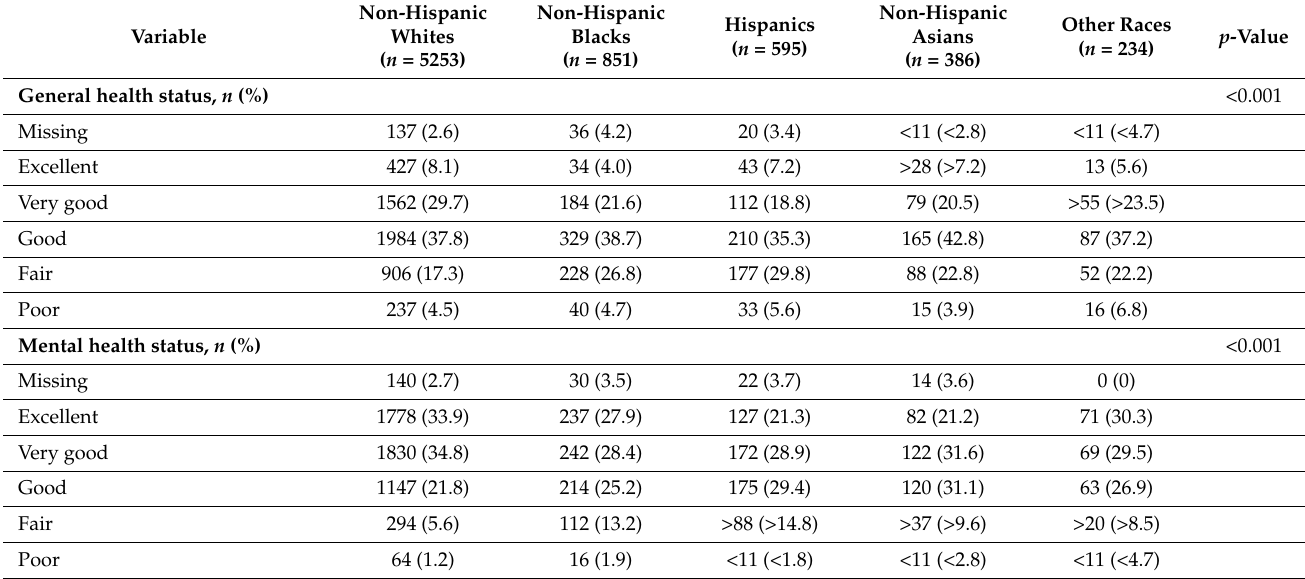
Table 3. Self-reported health status of study cohort by race/ethnicity a